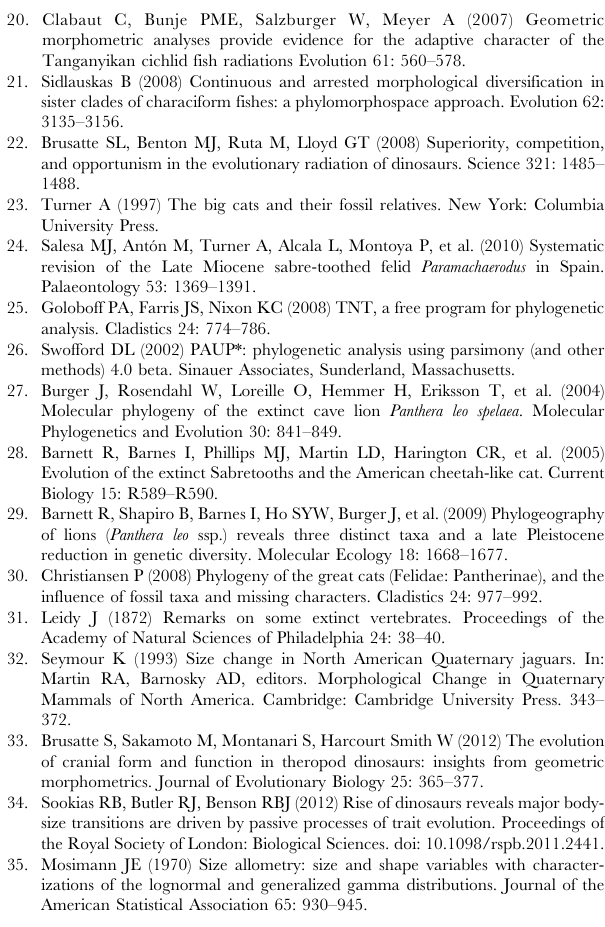
classification) assigned the classifications according to the columns, with correct classifications in blue and incorrect classifications in pink. For instance, the total number of specimens in the Bay Cat lineage is 13 but only 9 have been correctly assigned to the Bay Cat lineage, while 3 have been classified as Caracal lineage and 1 as Puma lineage; the accuracy is the proportion 9/13=0.692. Table S8 Prior classifications, predicted classifications, and posterior probabilities in LDA for each specimen. The prior classifications and classifications predicted by LDA is shown, with correct classifications in blue and incorrect classifications in pink. Posterior probabilities for each specimen are also shown. Table S9 Scores of all specimens on all PC axes. The Mosimann transforms were subjected to PCA and the first 11 PC axes were used for subsequent analyses. The scores of each specimen along all 29 PC axes are presented here. Table S10 NPMANOVA post-hoc pairwise comparisons be- tween lineages using PC1–PC11. The upper off-diagonal cells are F - values while the lower off-diagonal cells are p -values with sequential Bonferroni significance. Significant p -values are highlighted in